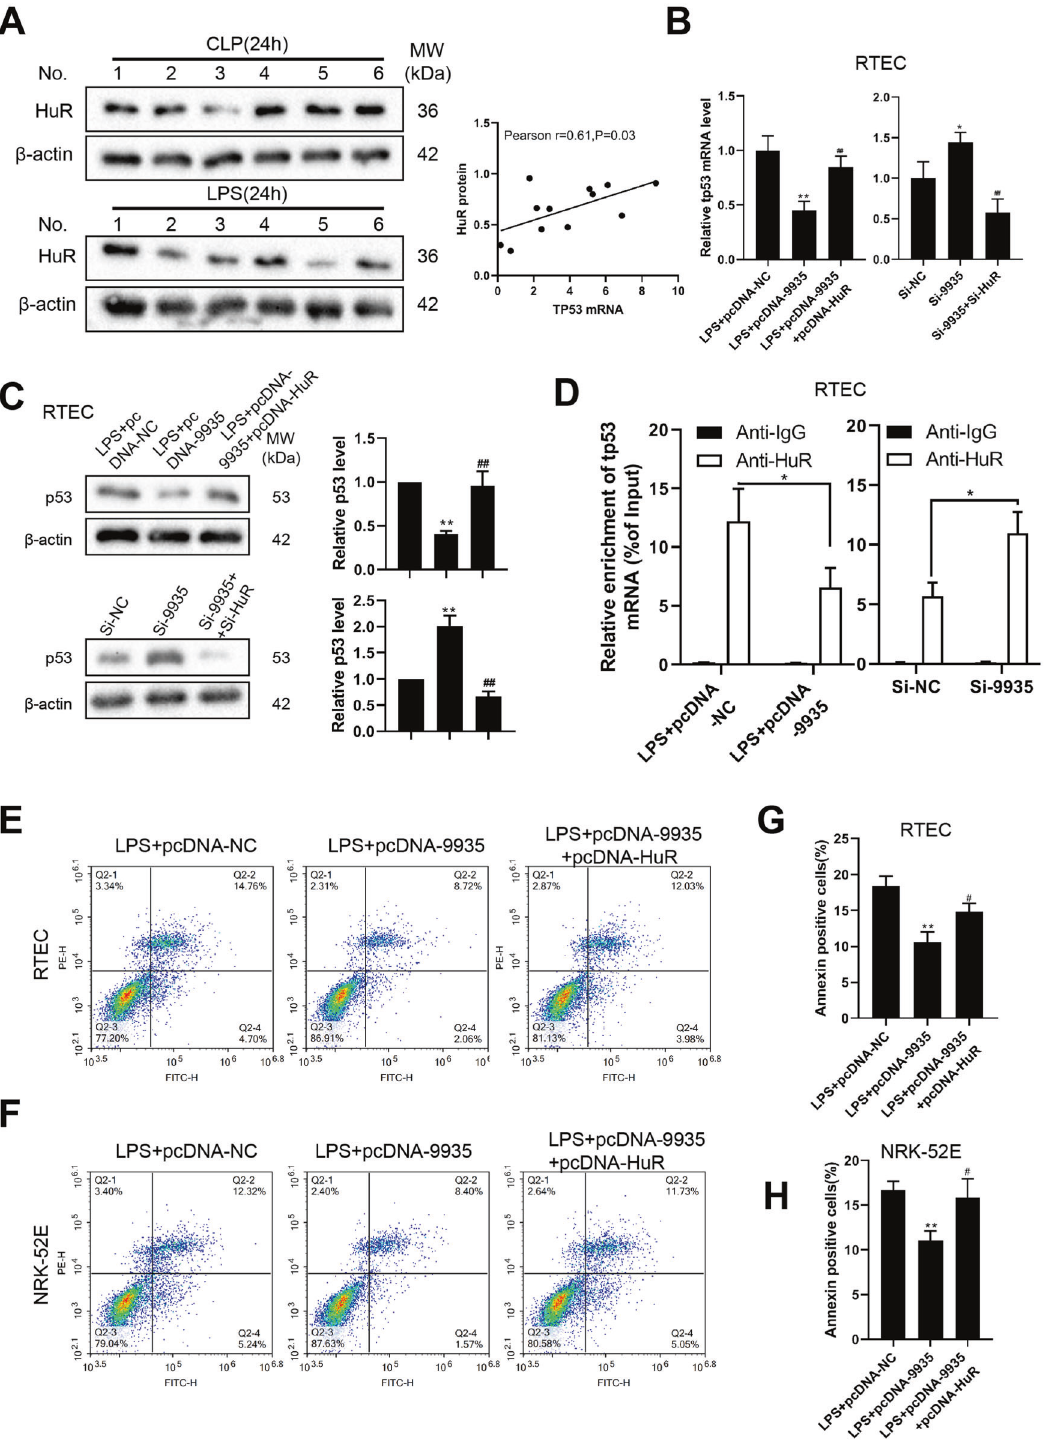
Fig. 6 LncRNA 9935 overexpression suppressed LPS-induced RTEC apoptosis through HuR/p53 axis. A HuR protein level was measured in the rat model of septic AKI induced by CLP or LPS using western blot. The correlation between the HuR protein level and Tp53 mRNA was assessed. B , C The in fl uence of 9935 and HuR on p53 expression was measured in rat primary RTECs. * P < 0.05,** P < 0.01 vs. LPS + pcDNA-NC or si-NC; ## P < 0.01 vs. LPS + pcDNA-9935 or si-9935. D RIP was performed to detect the in fl uence of 9935 on the combination of HuR and Tp53 mRNA in RTECs. * P < 0.05. E – H The in fl uence of 9935 and HuR on LPS-induced cell apoptosis was performed on primary RTECs and NRK- 52E cells using fl ow cytometry. The representative fl ow scatters plots and quantitative results were shown. ** P < 0.01 vs. LPS + pcDNA-NC; # P < 0.05 vs. LPS +